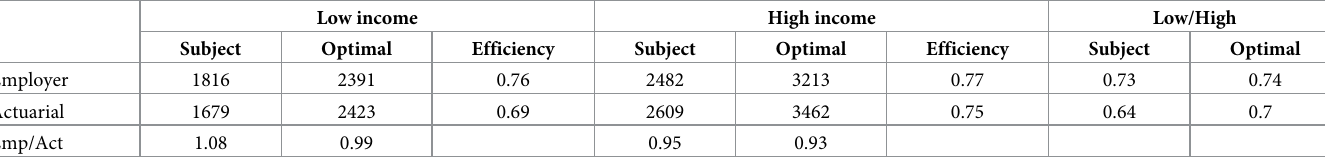
Table 5. Mean joy